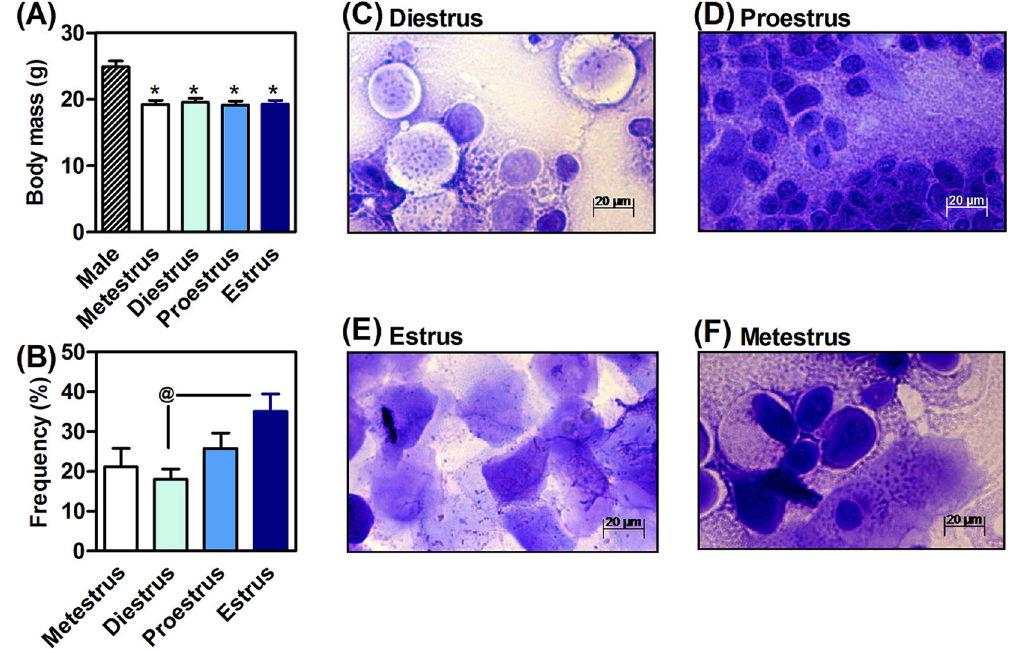
Figure 1. Impact of sexual dimorphism on body mass ( A ) and analysis of the estrous cycle based on a morphological analysis of vaginal smears ( C – F ) that revealed that the prominent estrous cycle was estrus ( B ). Values are expressed as mean ± standard error of the mean (SEM). N = 8–10 animals/group. * P < 0.05 vs . male (ANOVA, Bonferroni post hoc test). @ P < 0.05 (Kruskal-Wallis